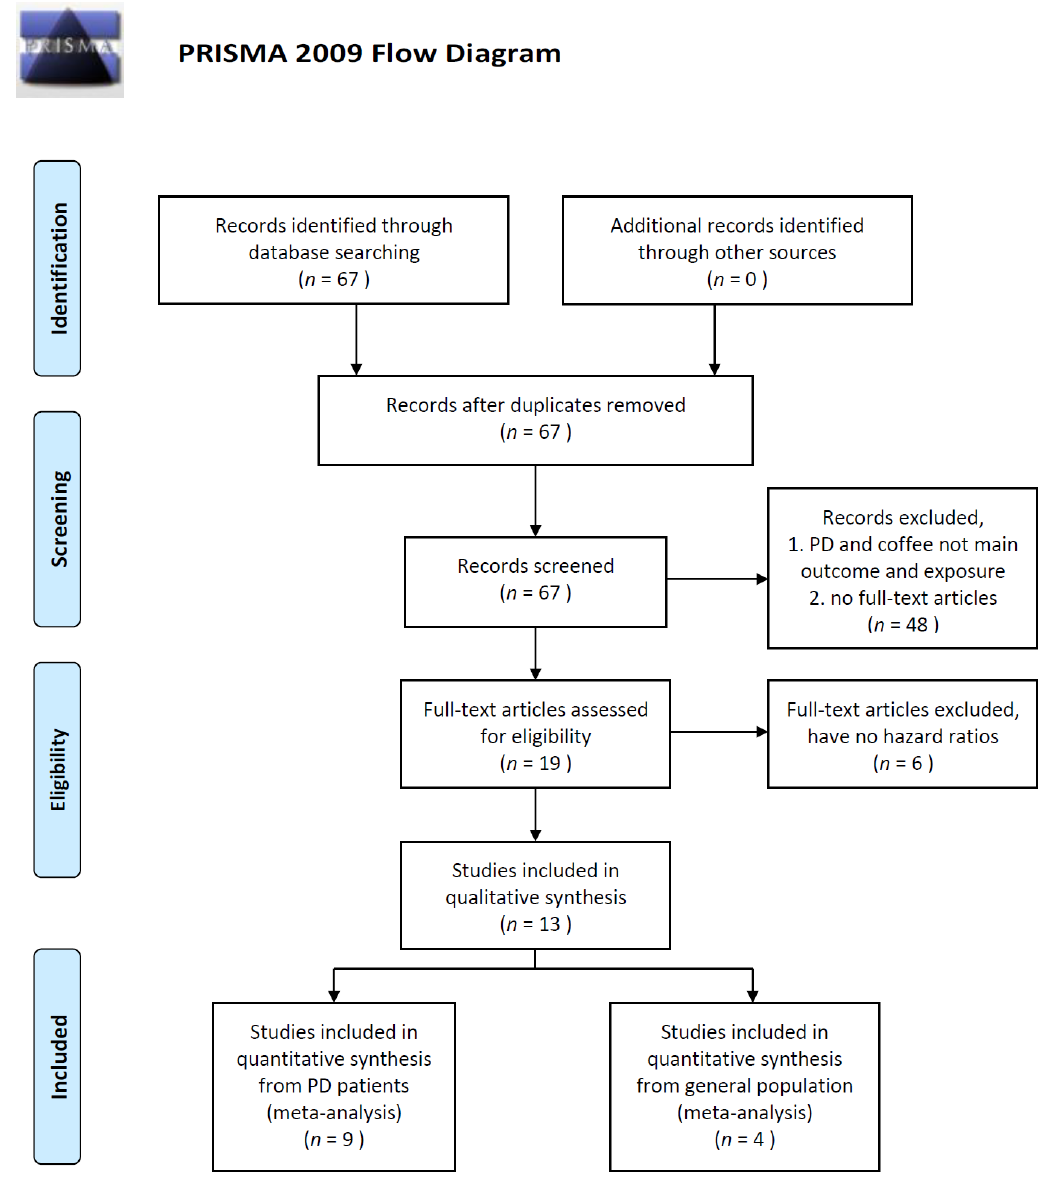
Figure 1. A schematic representation of the literature search.